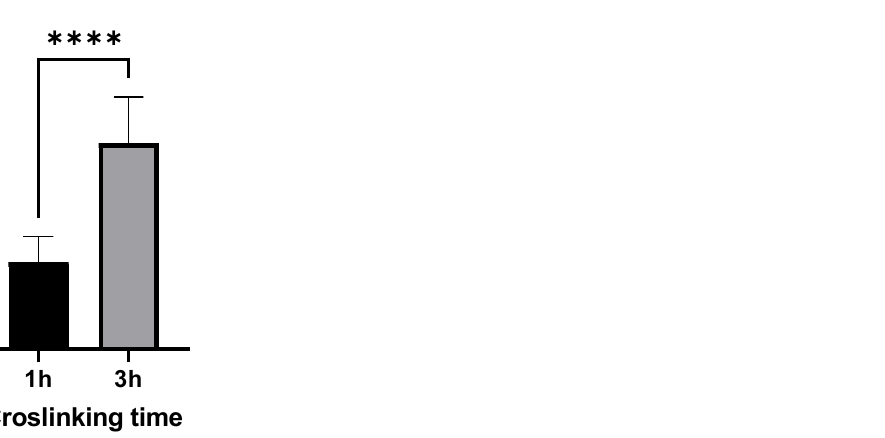
Figure 2. AFM height image of 1 and 3 h crosslinked GNPs measured in liquid at 37 °C, showing a number-based size of 217 ± 52 and 224 ± 65 nm.